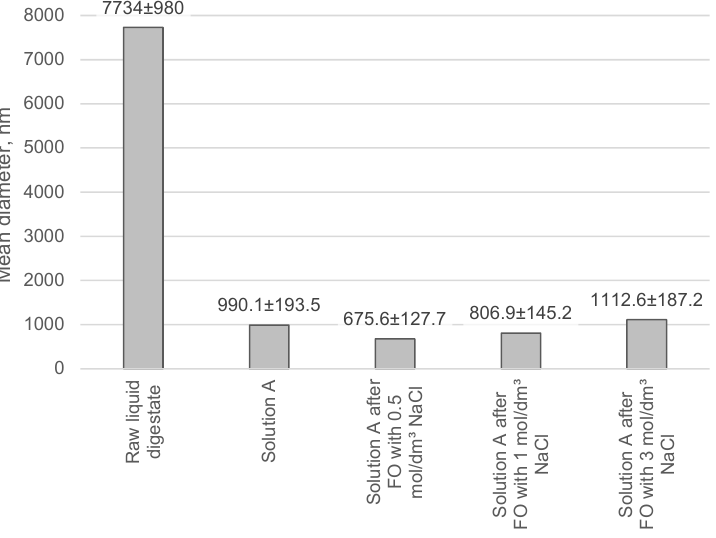
Figure 9. Average particle diameter in the tested solutions after struvite precipitation and FO. The results of particle size distribution analyses based on the laser diffraction method are shown in Figures 10 and 11. This method is employed under conditions of continuous mixing and pumping of the dilute dispersion through the measuring cell. In this case, there is no possibility of sedimentation of larger particles, which is otherwise common in dynamic light scattering measurements, where the sample is placed in a cuvette and larger particles settle on the bottom. For the raw digestate, lower and upper deciles of about 1 µ m and 34 µ m were obtained, respectively, and half of the particle population had diameters of up to about 7.7 µ m. Sonication of the sample during measurement of the particle size distribution of the raw digestate allowed the individual diameters (d 10 , d 50 and d 90 ) to be reduced to 0.8, 4.6 and 23 µ m, respectively (Figure 10). The analysis of particle size distribution in solution A (Figure 11) revealed that the diameters of d 50 and d 90 decreased to 2 µ m and 19 µ m, respectively, compared to the values obtained for the raw digestate. In contrast, the lower decile remained virtually unchanged (about 0.9 µ m). The use of an integrated process combining struvite precipitation with FO did not practically change the particle size distribution in terms of the finest and medium fractions. The only noticeable differences were in the share of the largest particles. The results confirm that the digestate particles form agglomerates that can be easily broken